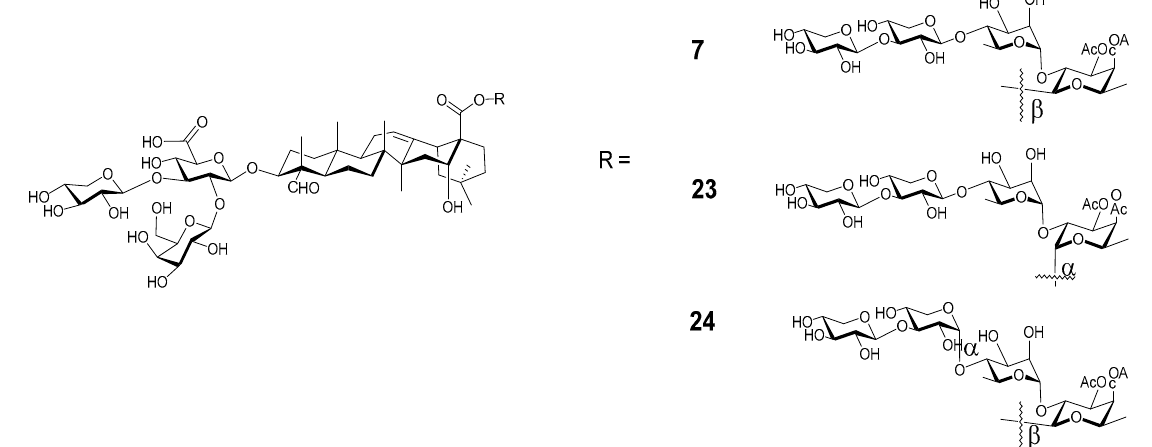
Figure 9. Synthetic QS isomeric analogs having different stereocenters.